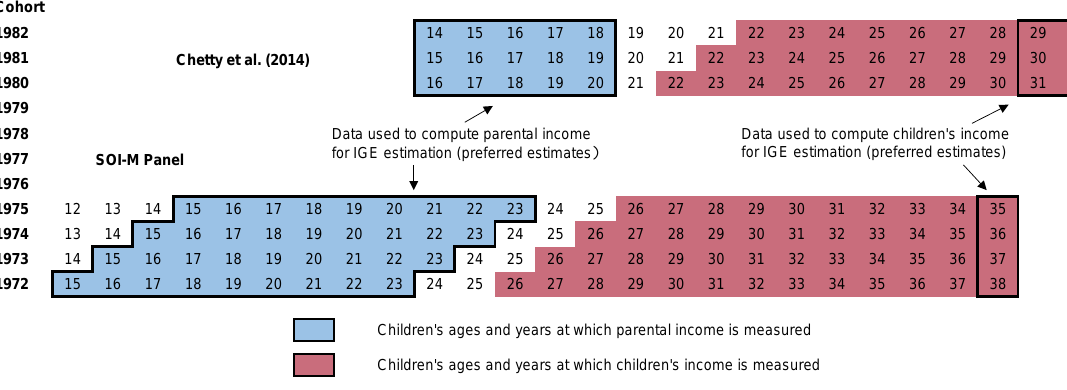
Figure 3: Comparison of Chetty et al.’s (2014) data and the SOI-M best